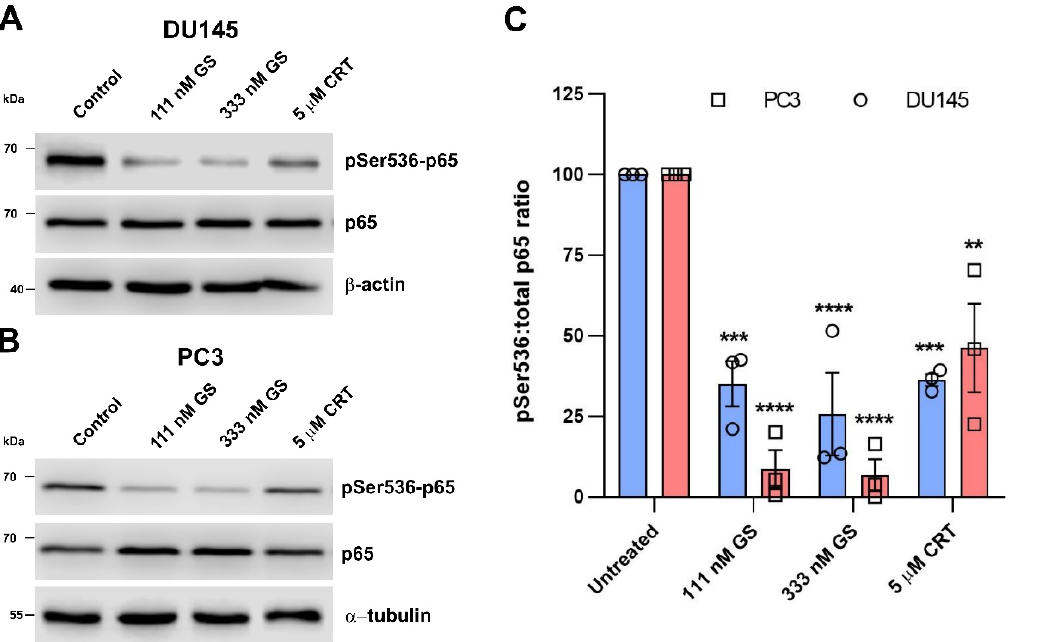
Figure 4. Hsp90 and PKD inhibition impedes Ser536 phosphorylation of the NF- κ B subunit p65. Representative Western blots of lysates from DU145 ( A ) and PC3 ( B ) cells treated with 111 or 333 nM GS or 5 µM CRT0066101, respectively, for 4 h. ( C ) Densitometric analysis (mean ± SEM) from three independent experiments. ** p < 0.01, *** p < 0.001, **** p < 0.0001, (two-way ANOVA with Tukey’s multiple comparison test).